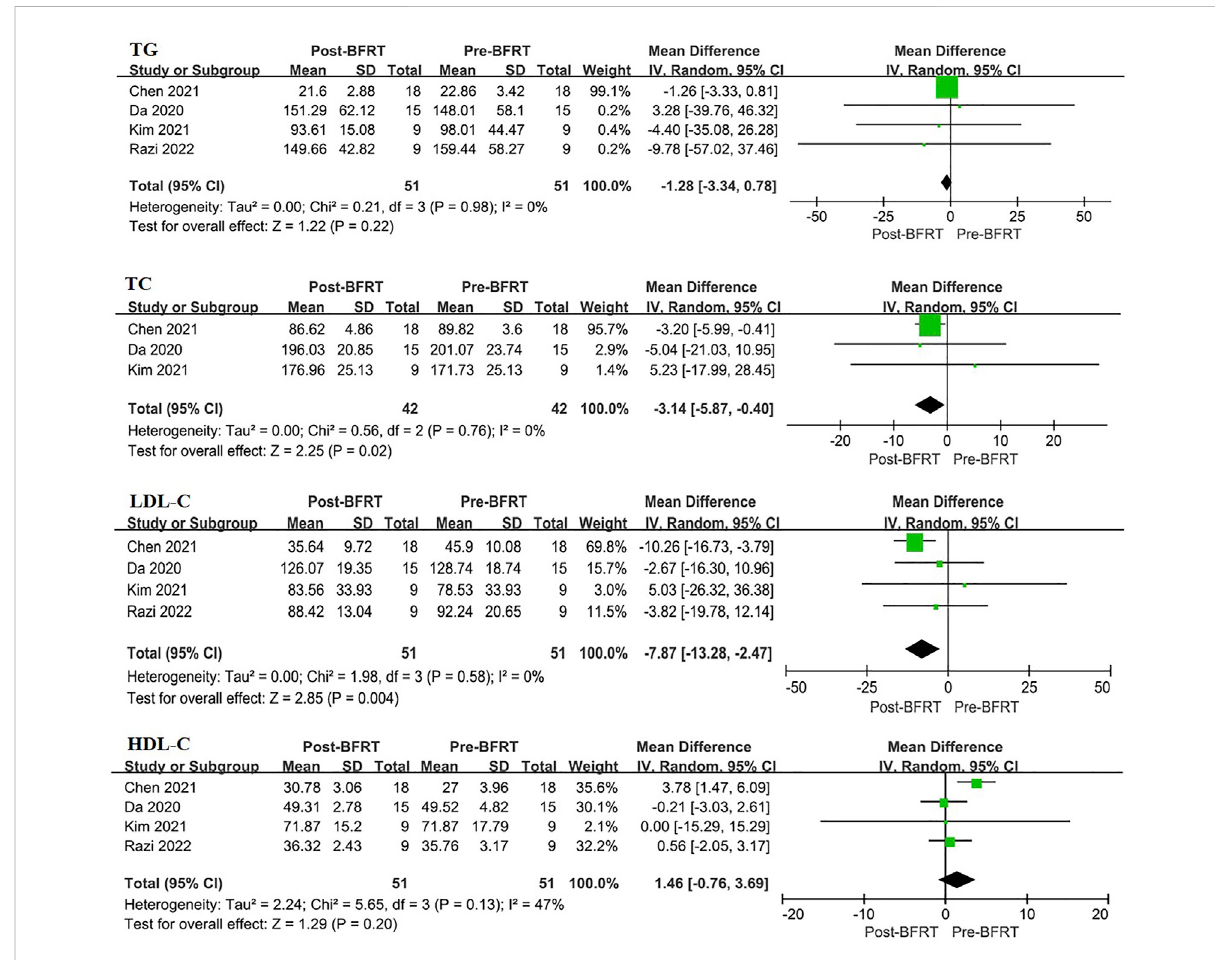
FIGURE 4 Forestplotdisplayingthedifferenceinbloodlipidsbetweenexperimentalgroupandcontrolgroupforeachindividualcase.TG,triglyceride;TC, total cholesterol; LDL-C, low-density lipoprotein cholesterol; HDL-C, high-density lipoprotein